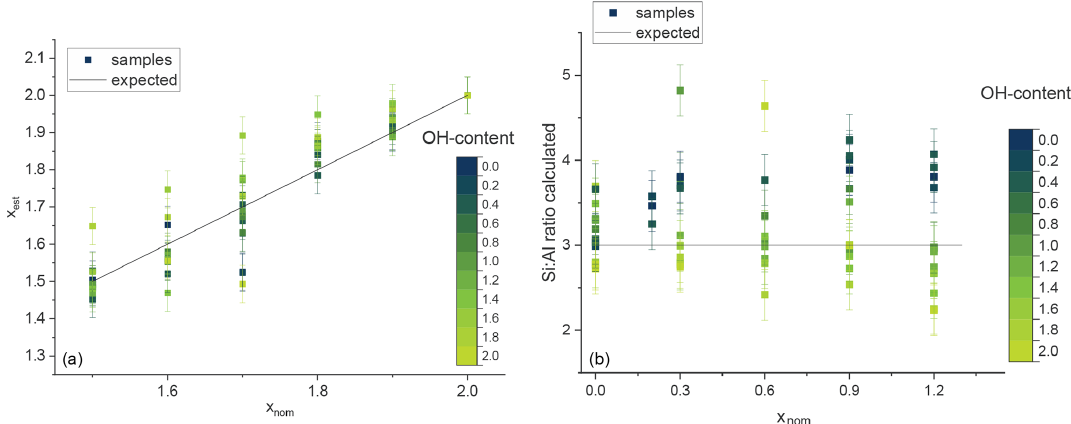
Figure 8. The estimated Li content plotted against the nominal composition given in the synthesis (a) and the Si / Al ratio plotted against the nominal x content (b) . The OH content is given by the blue and green colours. The black line shows the expected statistical